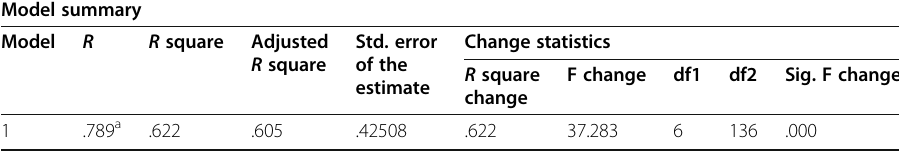
Table 2 Regression analysis Model summary